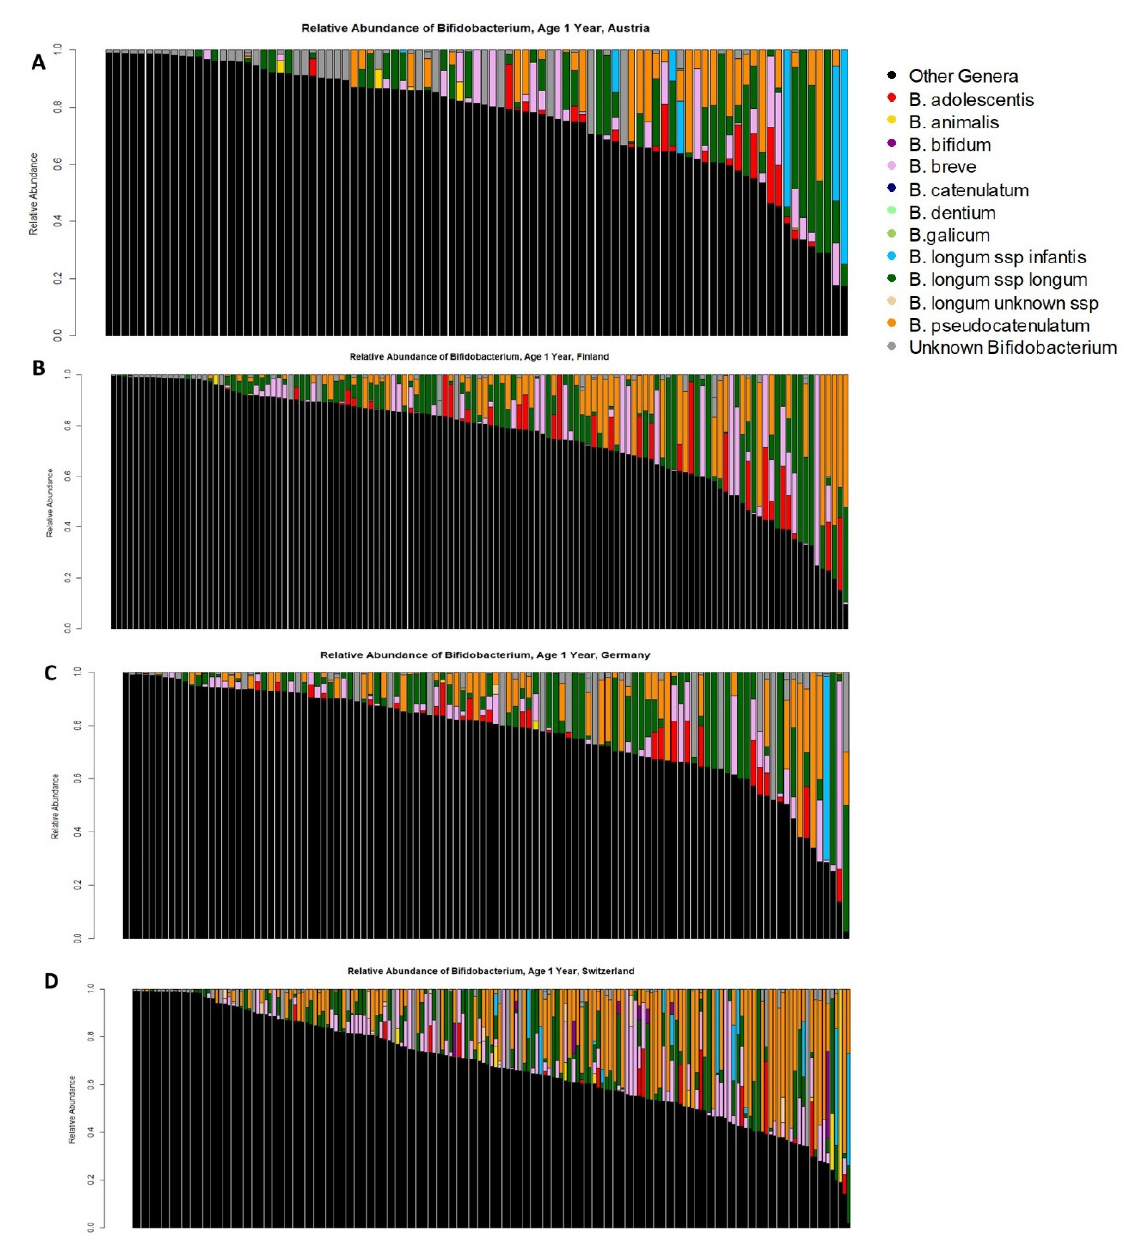
Figure 5. Bifidobacterium colonization in infants aged 1 year in ( A ) Austria, ( B ) Finland, ( C ) Germany, and ( D ) Switzerland. Table 5. Summary of Bifidobacterium prevalence in infants aged 1 year.